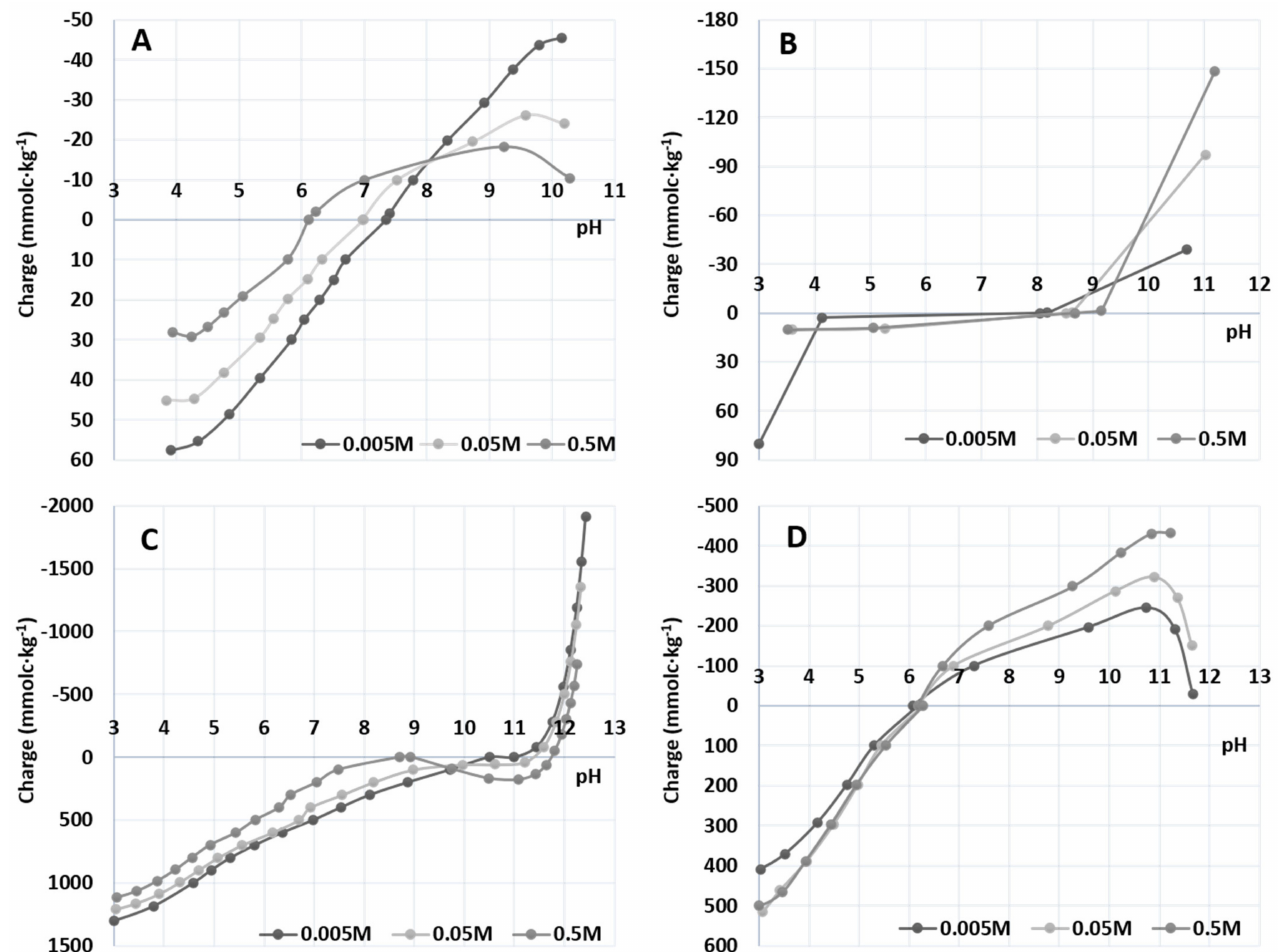
Figure 3. PZC of 2L-Fh ( A ), Goethite ( B ), AMO ( C ) and FMBO ( D ). Three ionic force was assayed: 0.005, 0.05 and 0.5 M.